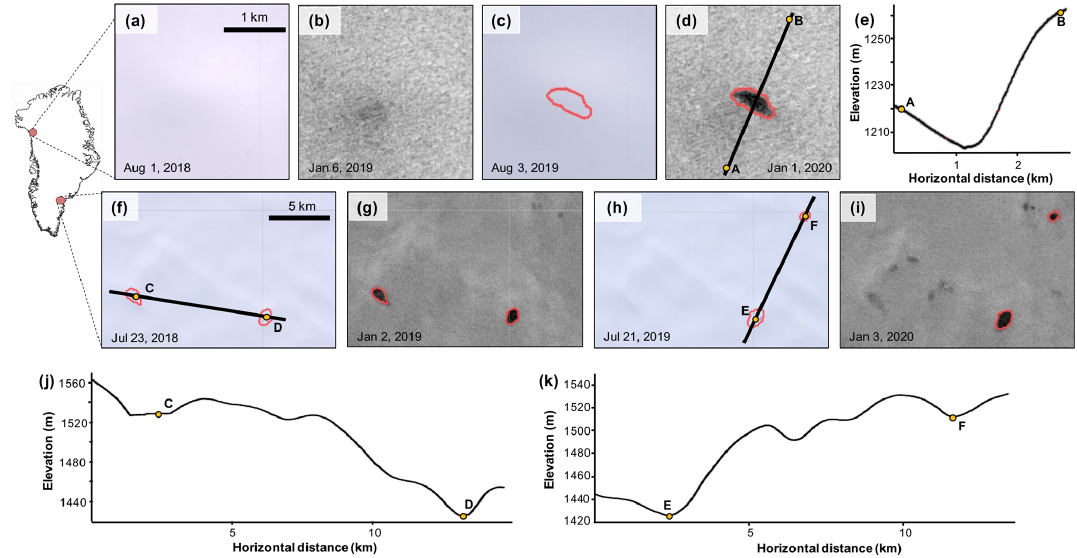
Figure 9. Optical and microwave images and surface elevation profiles of buried lakes in NW Greenland (a–e) and SE Greenland (f–i) in chronological order. (a) S2 image from 1 August 2018. (b) S1 image from 6 January 2019. (c) S2 image from 3 August 2019 with post-2019 melt season buried lakes outlined in red. (d) S2 image from 1 January 2020. (e) Surface elevation profile from Arctic DEM Mosaic (Porter et al., 2018) over the buried lake shown in (d) . (f) S2 image from 23 July 2018 with post-2018 melt season buried lakes outlined in red. (g) S1 image from 2 January 2019. (h) S2 image from 21 July 2019 with post-2019 buried lakes outlined in red. (i) S1 image from 3 January 2020. (j) Surface elevation profile from ArcticDEM Mosaic over buried lakes C and D detected following the 2018 melt season. (k) Surface elevation profile from ArcticDEM Mosaic over buried lakes E and F detected following the 2019 melt season.